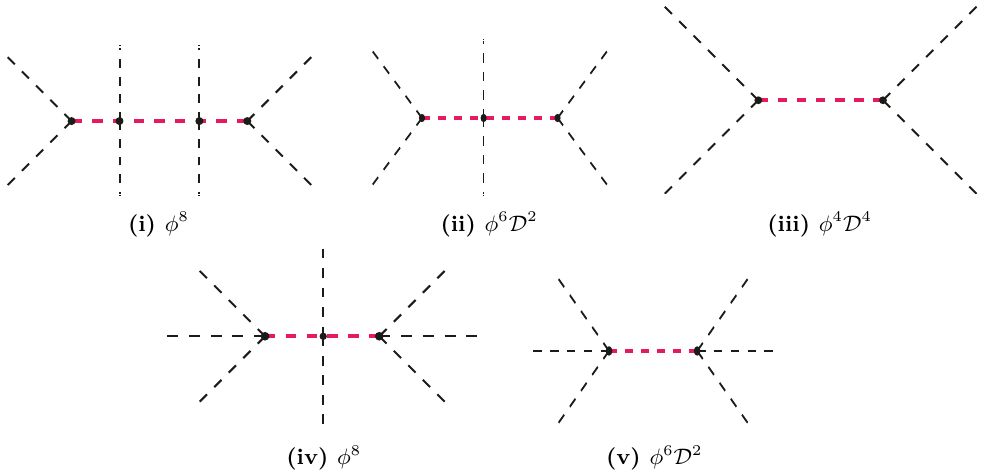
Figure 3. Schematic unfolding of φ 8 , φ 6 D 2 and φ 4 D 4 classes of D8 SMEFT operators into tree- level